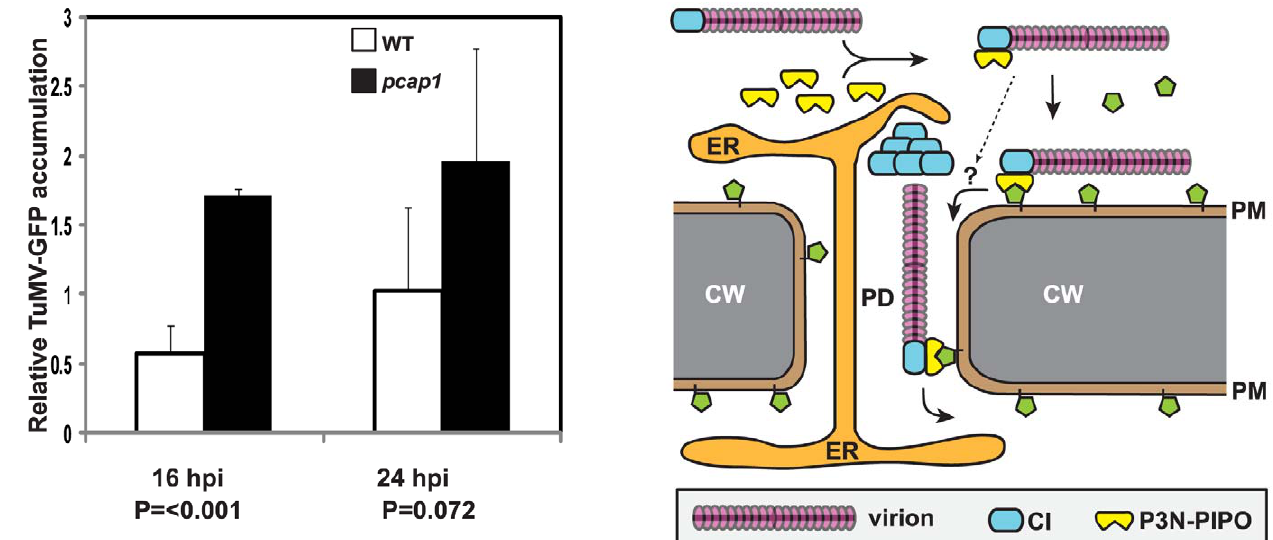
Figure 10. TuMV-GFP RNA accumulation in Arabidopsis proto- plasts. qRT-PCR was used to quantitate TuMV-GFP RNA accumulation in protoplasts at indicated time points. The values were normalized to the amounts of Actin8 transcript in the same samples. Data are average of three independent experiments, each consisting of three replicates. Error bars represent standard deviations. Statistical significance between WT and pcap1 was analyzed by the unpaired Student’s t - test and calculated P values are indicated.